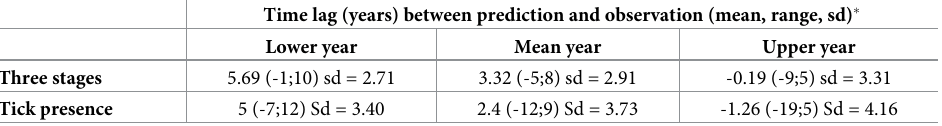
Table 2. Time lag between predicted tick establishment and detection of ticks by active surveillance. Mean, range and standard deviation of the time lag in years between predicted tick establishment and observation of a ticks (three stages or tick presence) in a municipality according to lower, mean and upper predicted year of